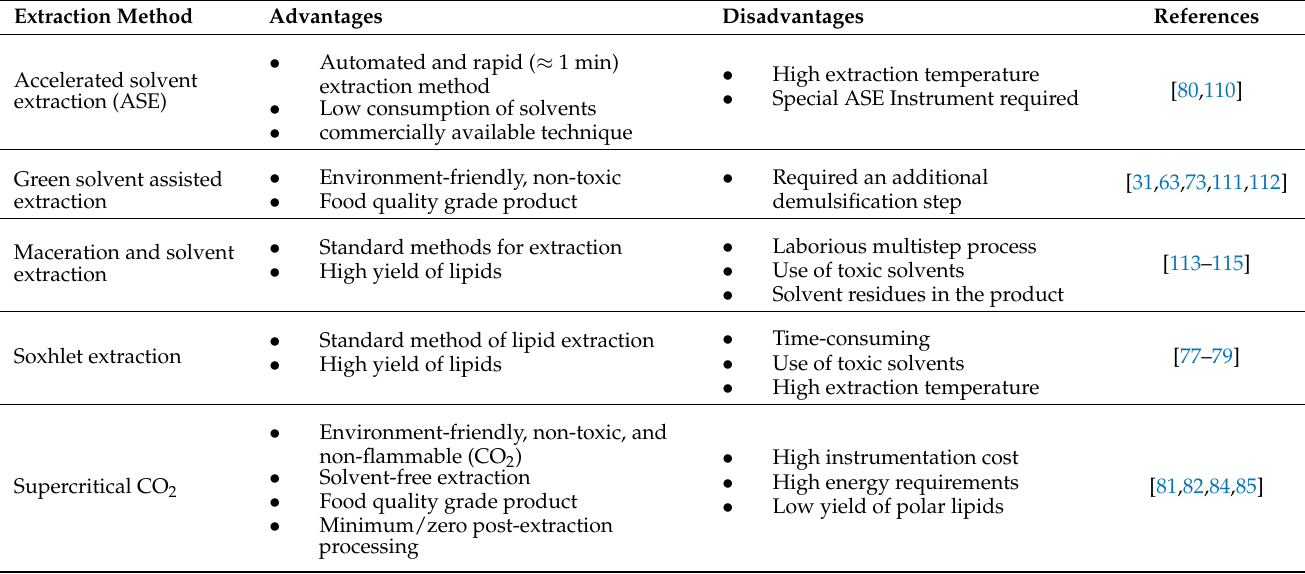
Table 5. Advantages and disadvantages of various lipid extraction